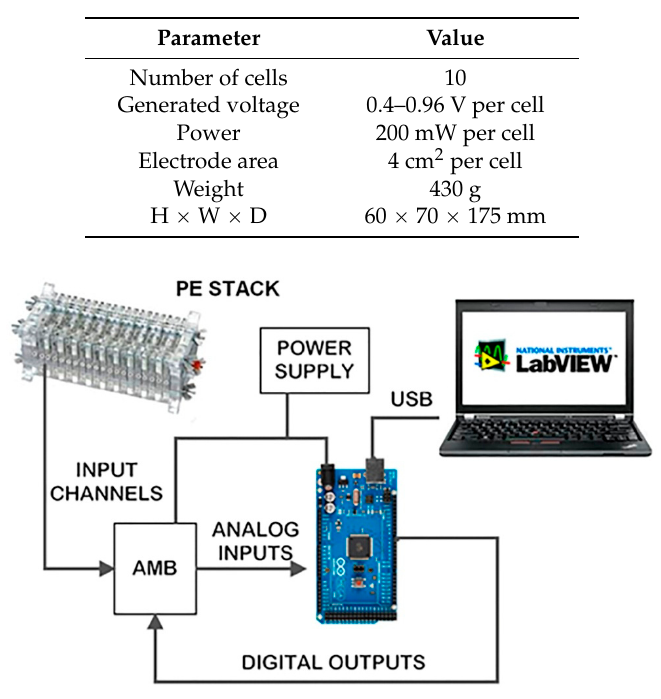
Figure 7. General block diagram of the experimental system.